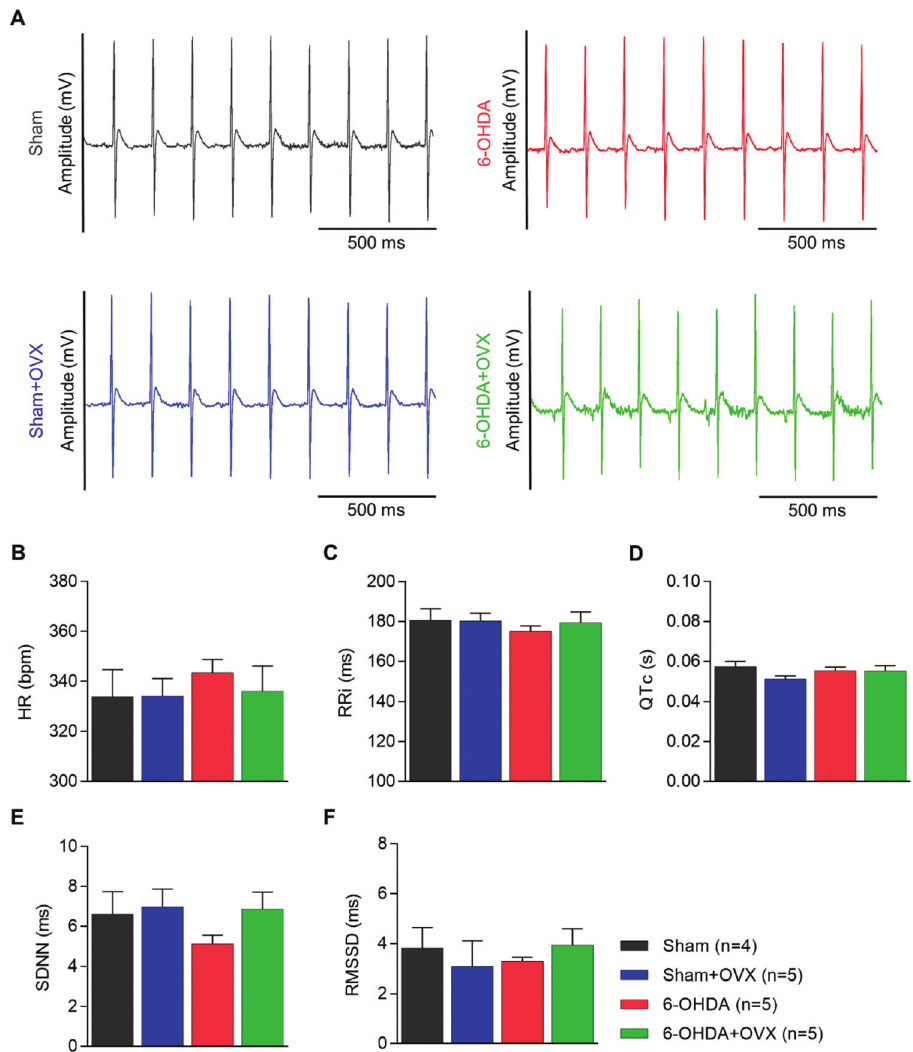
Figure 2 - Heart rate variability parameters (time domain analysis) (A) Electrocardiographic signal for each group. (B) Heart rate (HR), (C) the R-R interval (RRi), (D) the Q and T interval (QTc), (E) the standard deviation of all normal-to-normal intervals (SDNN), and (F) the square root of the mean of the squared differences between adjacent normal RRi (RMSSD). Data are expressed as mean ± standard error of the mean. Data are analyzed using GLM multivariate with the Sidak post-hoc test. Sham, n=4; Sham + OVX, n=5; 6-OHDA, n=5; 6-OHDA + OVX, n=5 (6-OHDA, 6-hydroxydopamine; OVX,